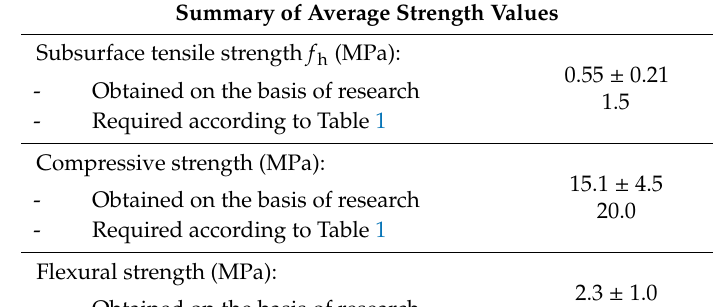
Table 2. Sample results of strength tests carried out for one of the cement floors tested in accordance with [46] (own study based on the data provided [25]) .